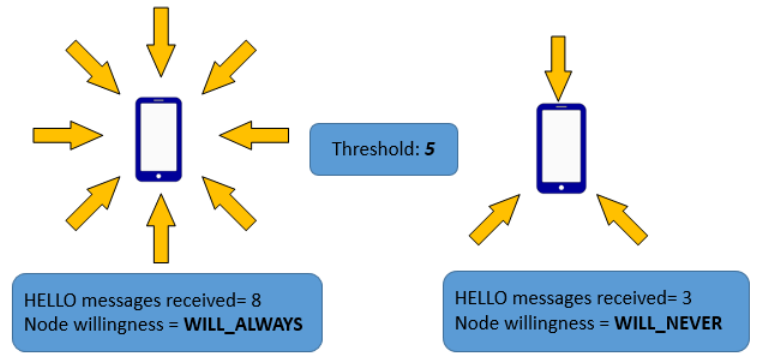
Figure 4. Node willingness selection based on the number of received HELLO messages.